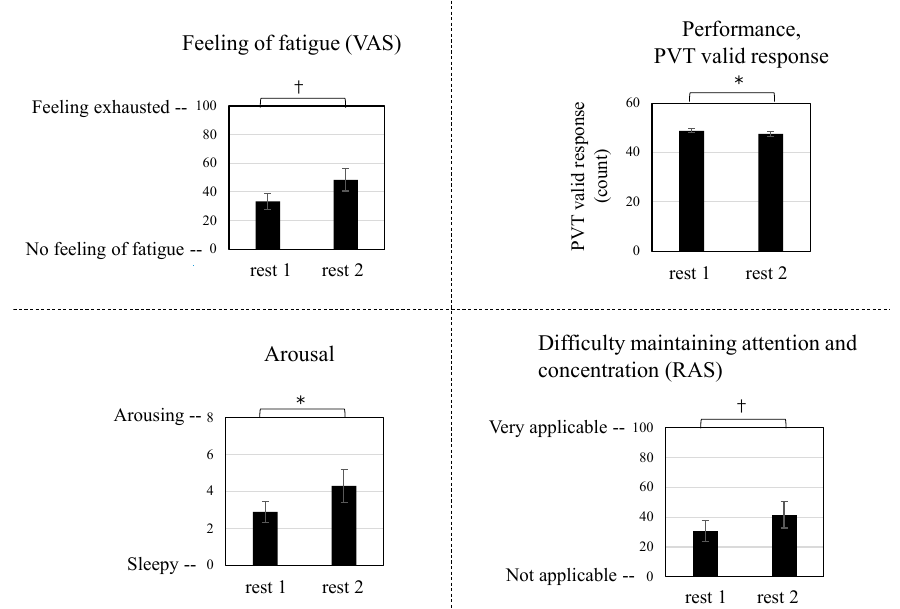
Figure 3. Change in subjective feeling and performance before and after the fatigue-inducing task. Data are expressed as mean ± standard errors ( n = 10). * p < 0.05, † p < 0.1. PVT, psychomotor vigilance task; VAS, visual analog scale; RAS, Roken Arousal Scale.